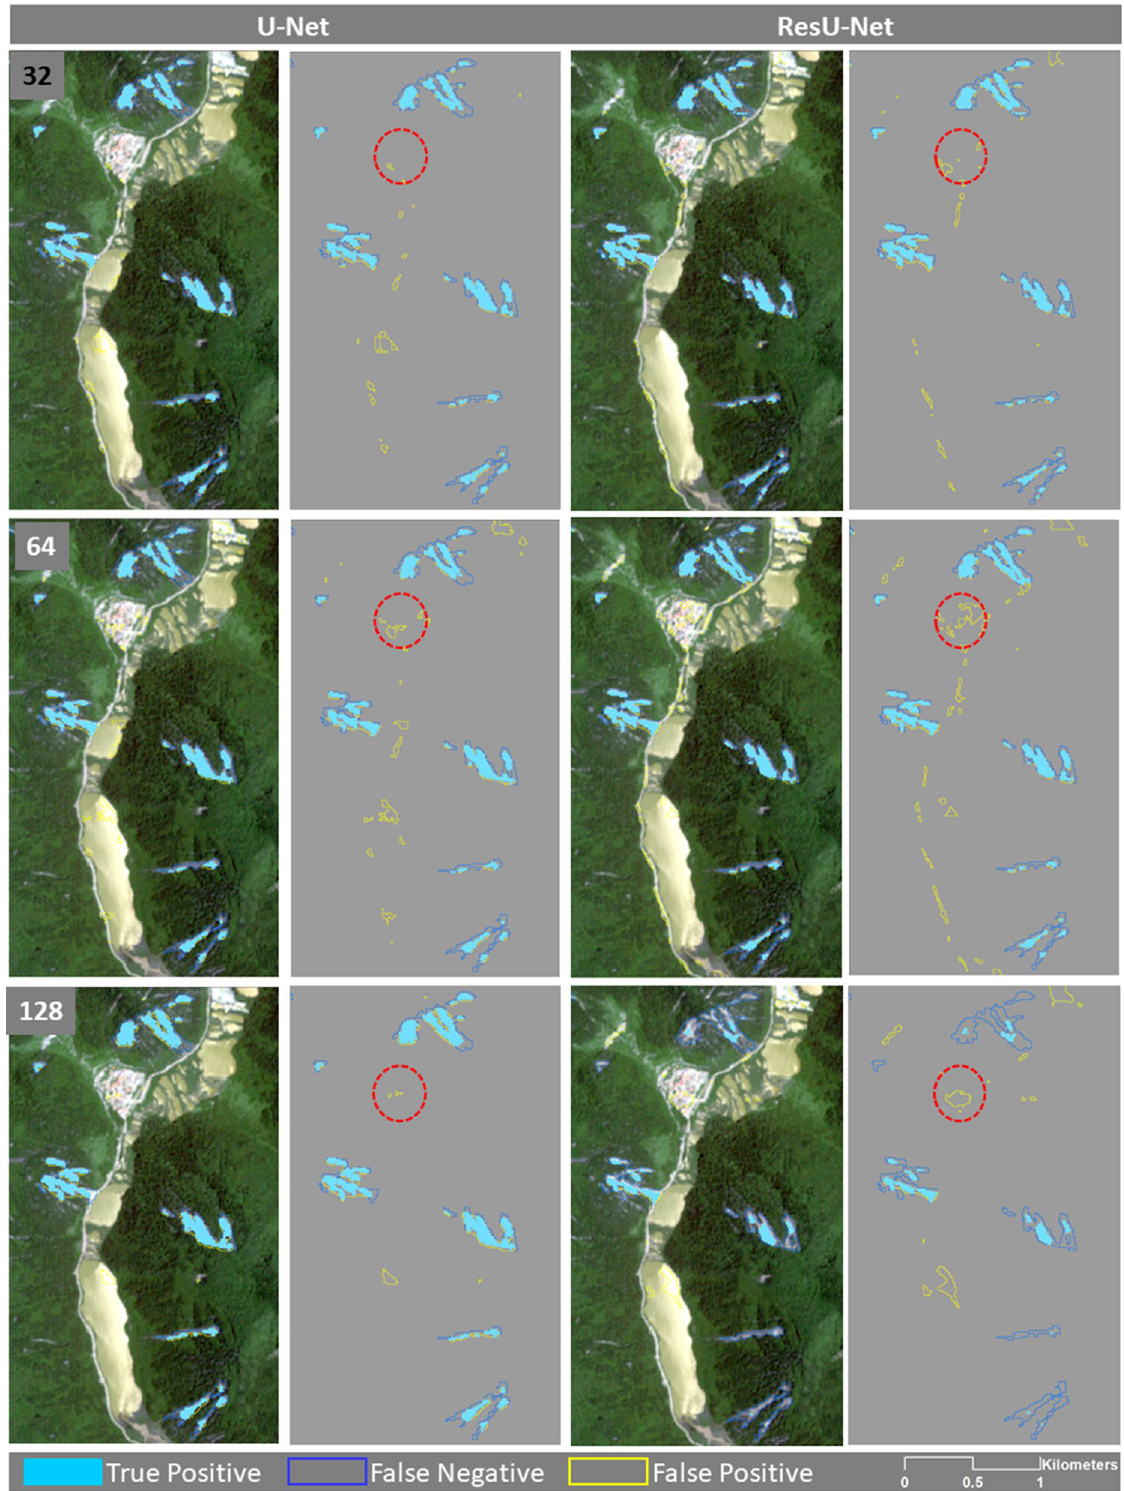
Figure 8. The enlarged areas of the results of the U-Net and ResU-Net trained and tested on China datasets using different sample patch sizes. Red ovals are showing examples of differences in the results. The maps were created using Python 3.6 (https:// www. python. org/) and the ArcMap v.10.8 software (https:// deskt op. arcgis. com/ es/